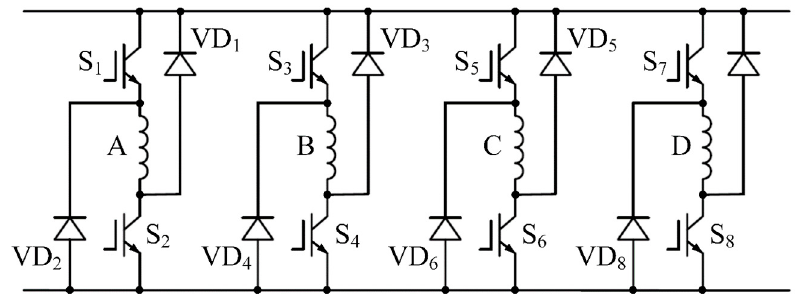
Figure 2. Topology of the power converter main circuit.